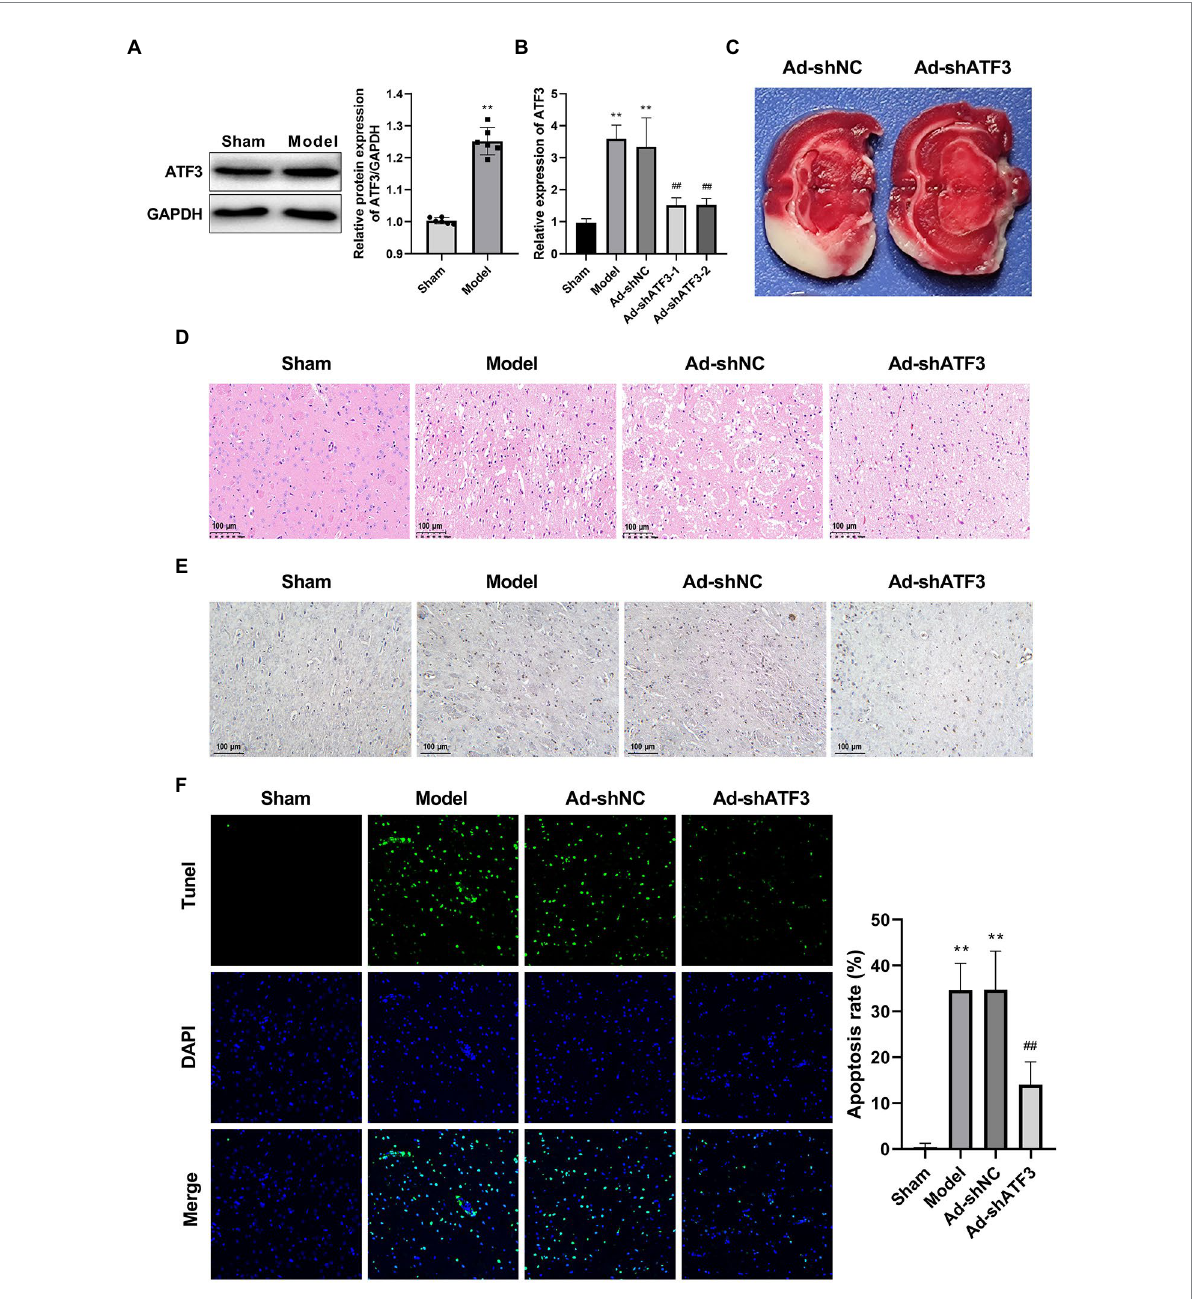
FIGURE 4 Knockdown of ATF3 suppressed the pathological injury of IS ( N = 6 each group). (A) Western blot of ATF3 expression at the protein level. (B) qRT- PCR analysis of the knockdown efficiency of ATF3 at the mRNA level. (C) TTC staining. (D) HE staining. (E) IHC staining for caspase-3. (F) TUNEL staining. ** p < 0.01 vs. Sham; ## p < 0.01 vs. Model.